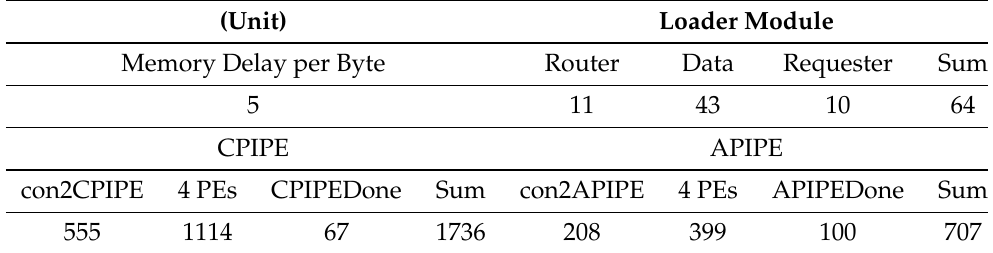
Table 2. Configuration parameters of sub-modules within the DLA for hardware